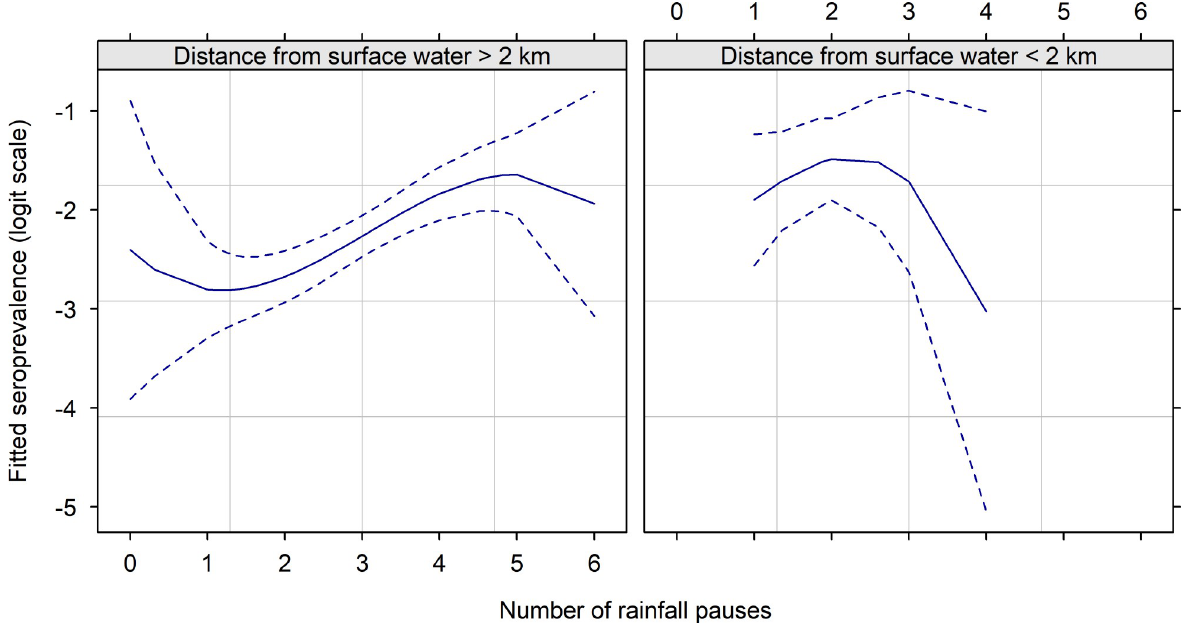
Fig 2. Logit of RVFV seroprevalence (solid line)—and 95% pointwise confidence interval (dashed lines), in small ruminants after the rainy season 2014 in Senegal, according to a spline function of the number of dry spells during the rainy season 2014, and conditionally on the distance to the nearest surface